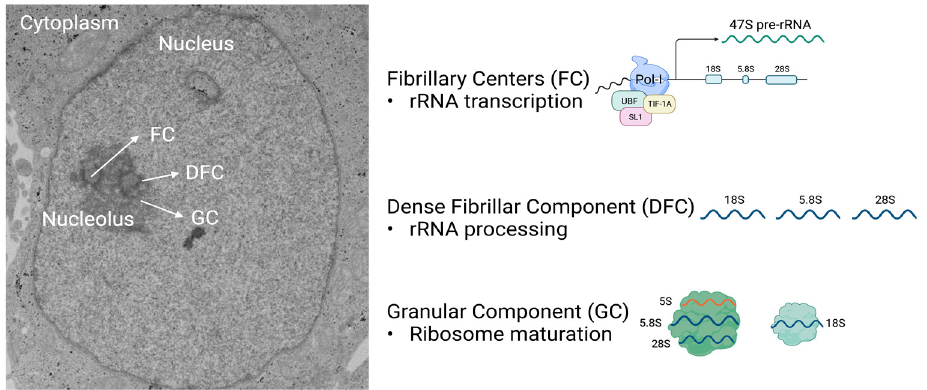
Figure 1. The nucleolus contains three distinct compartments responsible for pre-rRNA transcription, rRNA processing, and ribosome subunit assembly. The nucleoli are located within the nucleus (shown in the electron microscopy photo to the left) and are comprised of three sub-compartments: the fibrillary centers (FC), the dense fibrillar component (DFC), and the granular component (GC). The transcription of rDNA occurs in the FC upon the binding of selectivity factor 1 (SL1), which leads to the activation of the cofactors upstream binding factor (UBF) and TIF-1A, initiating RNAPolI to transcribe rDNA into 47S pre-rRNA. The 47S pre-rRNA is processed into 18S, 5.8S, and 28S rRNA in the DFC. Ribosome maturation proceeds in the GC, where additional RPs are wrapped around rRNAs. Figure created with Biorender.com (accessed on 31 January 2022).